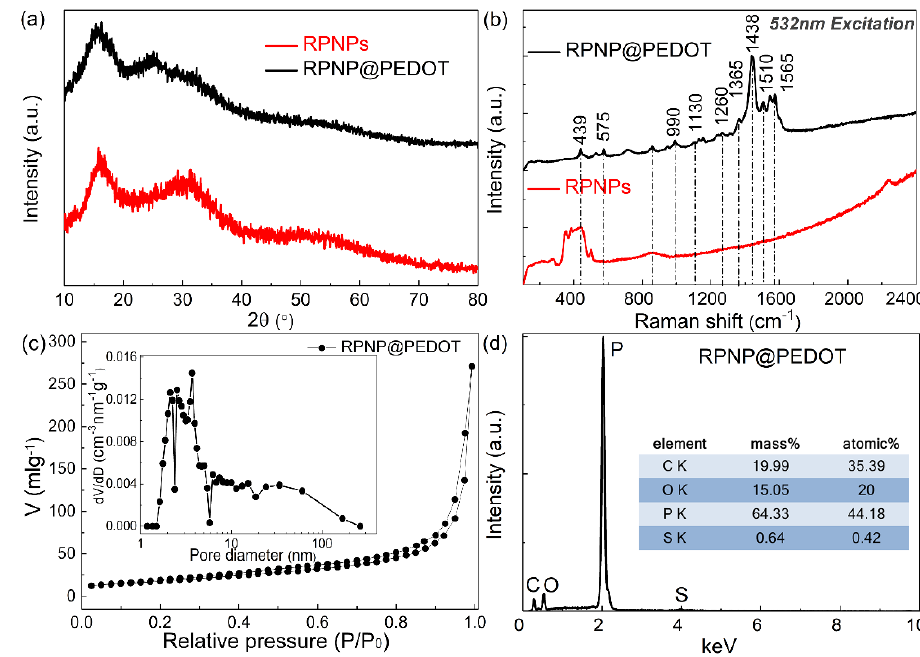
Figure 3. ( a ) XRD patterns and ( b ) Raman spectra of RPNPs (red) and RPNP@PEDOT (black); ( c )